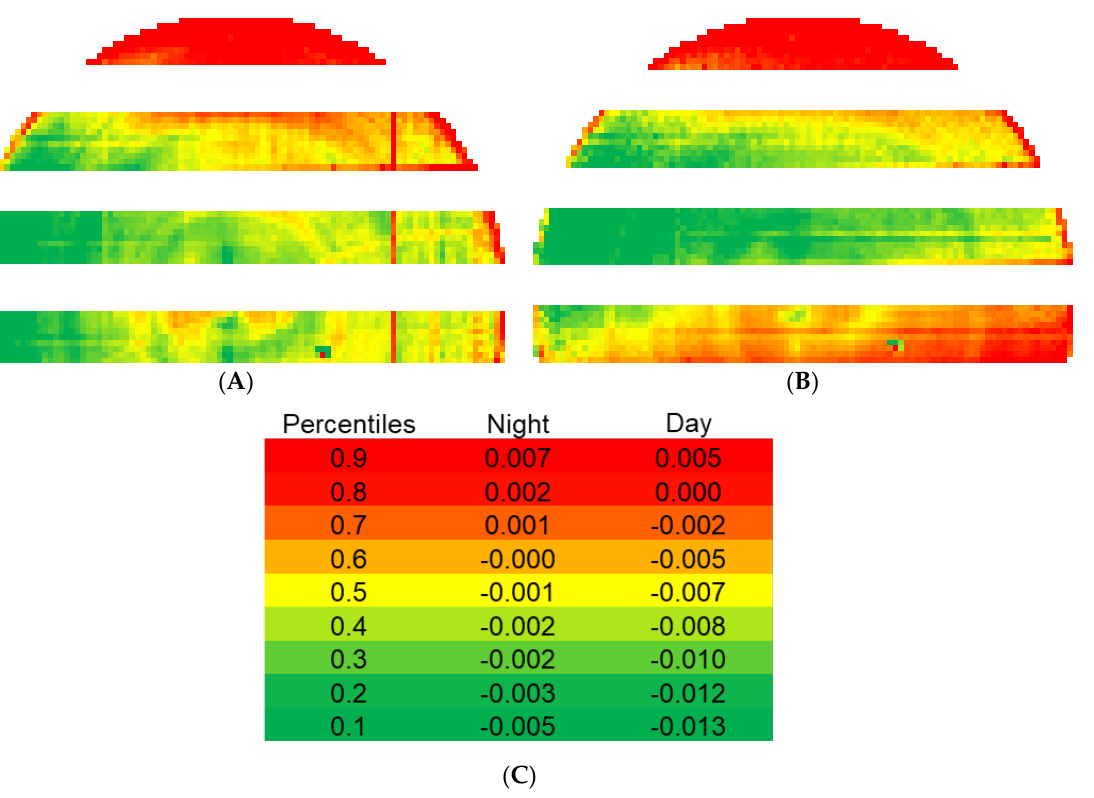
Figure 31. ( A ) Livox ® Mid–40 and ( B ) Riegl ® VZ-400 point clouds generated from observations of the target surface. CloudCompare [21] was used to register the two datasets using the targets towards extraction of conjugate points for measured distance comparison (RMSE of 0.007 m, and 0.005 m for night and day target registrations, respectively).